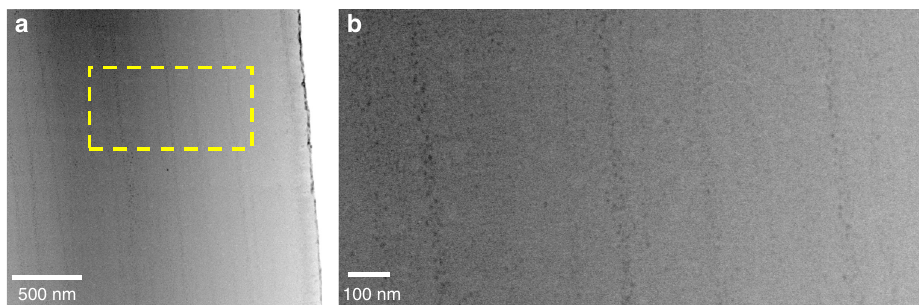
Fig. 2 The layered structure is caused by a layered distribution of high-Mg nanoparticles. a HRTEM (HAADF-STEM mode) of a FIB-cut lens lamella (cut perpendicularly to a lens surface – the lens surface can be seen at the right edge of the image) showing the existence of light (dark) nanoparticles distributed in layers parallel to the surface. b Zoom-in corresponding to the yellow square in (